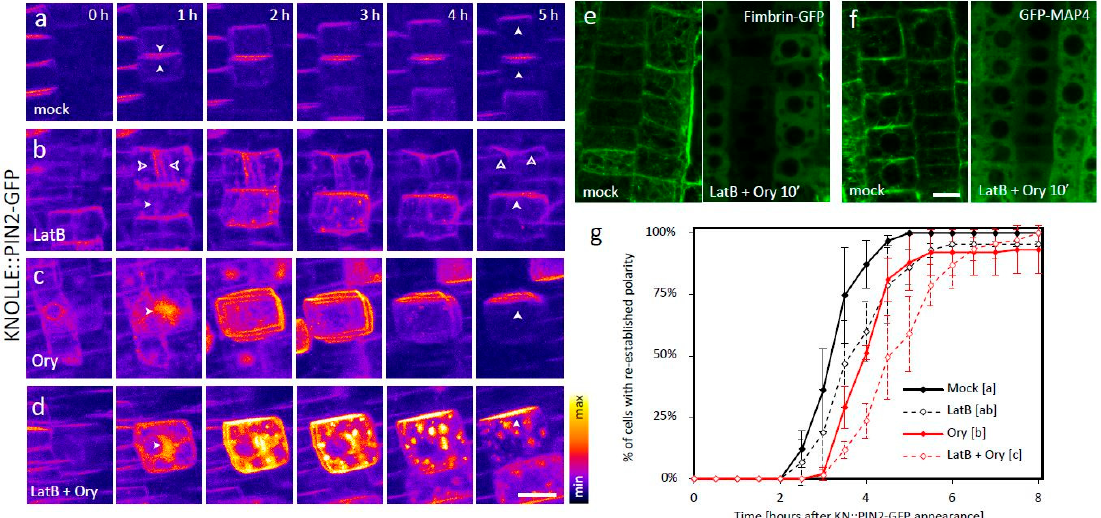
Figure1. ( a – d )EstablishmentofPIN2polarityinrootepidermalcells, visualizedbydynamiclocalization of PIN2-GFP expressed from the mitosis-specific KNOLLE promoter. ( a ) In a control situation, the signal localizes initially to the CP-derived new PM pair, and the apical polar distribution typical for PIN2 is reestablished 2–5 h afterwards [10]. n = 51 cells from six roots in three independent experiments. ( b ) In LatB-treated cells, part of the signal localizes to ectopic endomembrane compartments, but the distribution dynamics of the PM signal are similar to the control if the CP is formed (upper cell; empty arrows). Apical polar distribution also develops in cells where the treatment leads to cytokinetic failure and the signal is initially found in ectopic endomembrane aggregates instead of the CP (lower cell; full arrows). n = 87 cells from 11 roots in three independent experiments. ( c ) In Ory-treated cells, the signal is initially localized to a ball-shaped endomembrane aggregate that forms instead of the cell plate. Most of the signal is subsequently relocalized to the PM initially in an apolar manner, followed by development of apical polarity. n = 90 cells from 11 roots in three independent experiments. ( d ) Cells treated with both inhibitors at the same time display strict cytokinetic failure and signal localization to large, mostly immobile endomembrane aggregates, in addition to the PM. Nevertheless, apical polarity of the PM-bound signal is eventually also achieved in this case. n = 83 cells from nine roots in three independent experiments. ( e ) and ( f ) The markers Fimbrin-GFP ( e ) and GFP-MAP4 ( f ) confirm that the LatB + Ory cotreatment leads to fast and e ffi cient depolymerization of both actin and MTs, respectively. n = 19–20 roots from three independent experiments per line and treatment. ( g ) Quantification of the data presented in ( a )–( d ). The timepoint of KNOLLE::PIN2-GFP apical signal polarity establishment was marked for each cell, and the percentage of cells with established polarity in each condition was plotted against time. The mean +/ − SD of three independent experiments, each consisting of > 20 cells from 2–4 di ff erent roots (see n values in ( a )–( d )), is shown. The letters [a–c] indicate statistical significance based on the Kruskal–Wallis Rank Sum Test (post hoc analysis: Alpha: 0.01, p -value adjustment: Bonferroni), and the data points from all three experimental replicates were pooled for the purpose of statistical analysis. A typical LatB + Ory treated cell, as well as a rare one where polarity re-establishment failed, are shown in Video S2. Scale bars = 10 µ